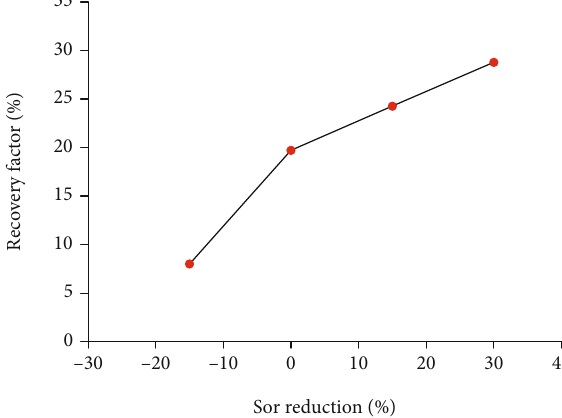
Figure 12: Ultimate recovery factors of reservoirs with di ff erent fracture spacing distances by cyclic surfactant